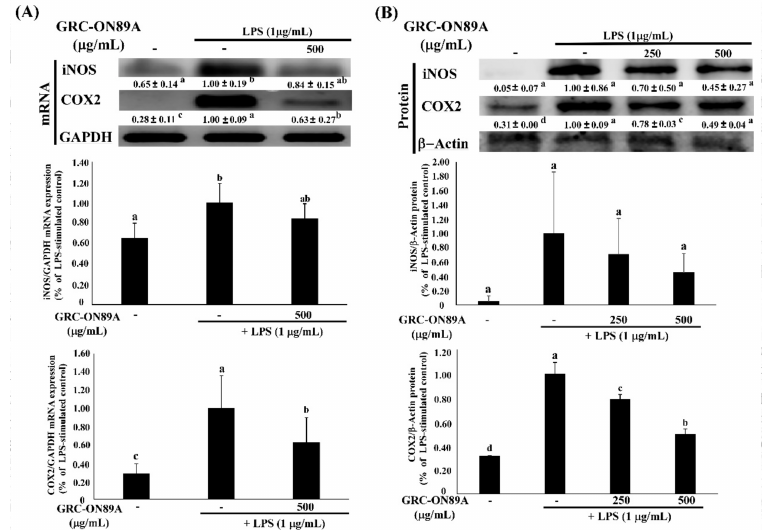
Figure 1. Hexane fraction of Cordyceps militaris grown on germinated Rhynchosia nulubilis (GRC) fermented with Pediococcus pentosaceus ON89A isolated from onion (GRC-ON89A-Hex) inhibited inflammatory cytokines. RAW 264.7 macrophages were pre-treated with GRC-ON89A-Hex extract for 2 h, and then stimulated with lipopolysaccharide (LPS, 1 µ g/mL). ( A ) The levels of inducible nitric oxide synthase (iNOS), and cyclooxygenase 2 (COX2) mRNA expression were analyzed by reverse transcription-polymerase chain reaction (RT-PCR). Glyceraldehyde 3-phosphate dehydrogenase (GAPDH) was used as an internal control; ( B ) The levels of iNOS and COX-2 protein expression was measured using western blotting. β -Actin expression was used as an internal control for western blot analysis. One-way analysis of variance (ANOVA) was used to compare group means, followed by Duncan t- test. Different letters show significant differences between groups at p < 0.05. Data are expressed as means ± standard deviation (SD) of independent experiments ( n ≥